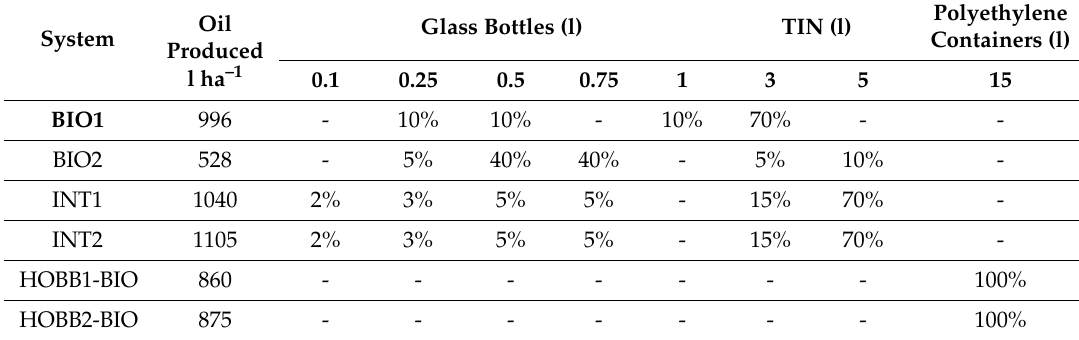
Table 5. Types and combinations of packaging used by the analyzed systems.